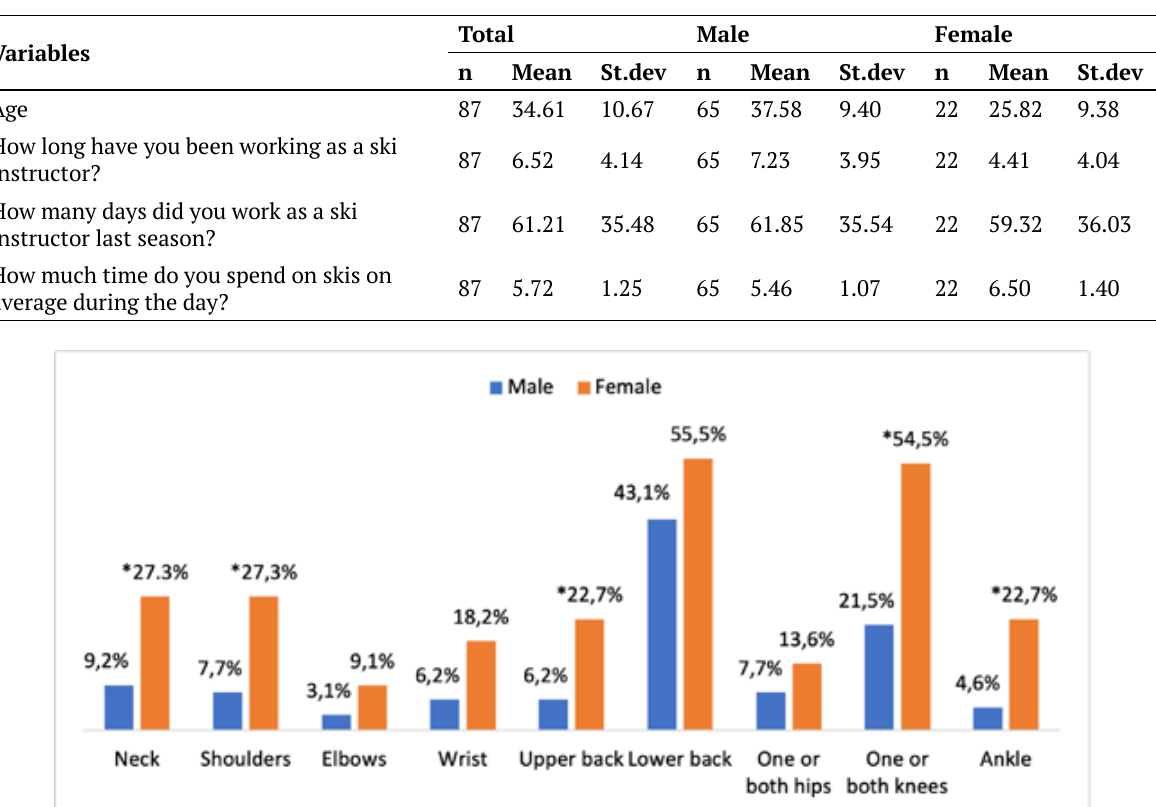
Table 1. Characteristics of participants